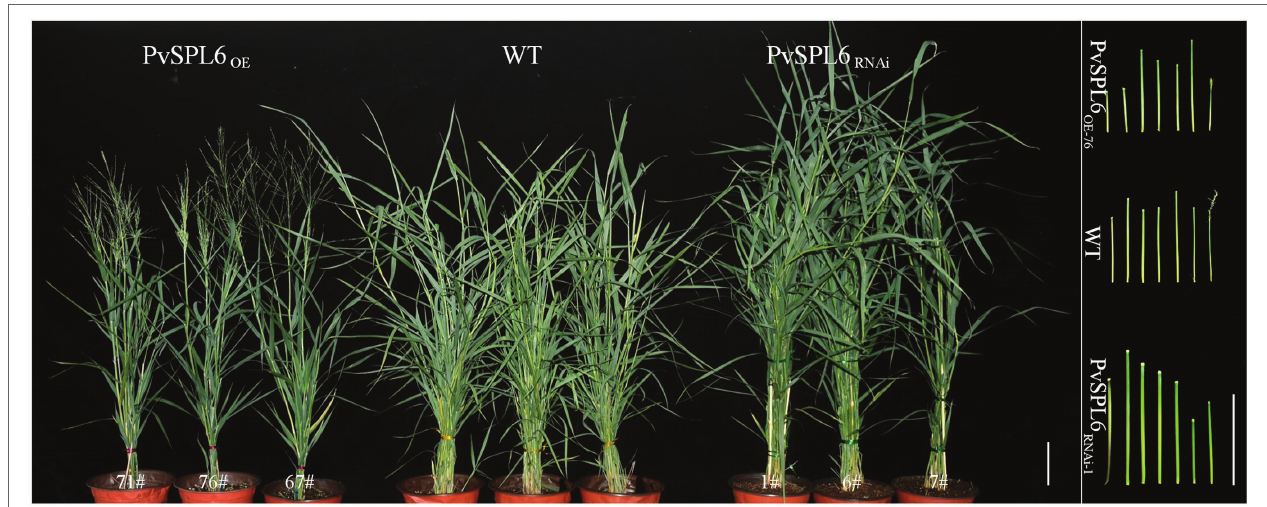
FIGURE 3 | Morphological characterization of PvSPL6 transgenic switchgrass plants. Morphological characterization of PvSPL6 OE and PvSPL6 RNAi transgenic switchgrass plants. Scale bar = 10